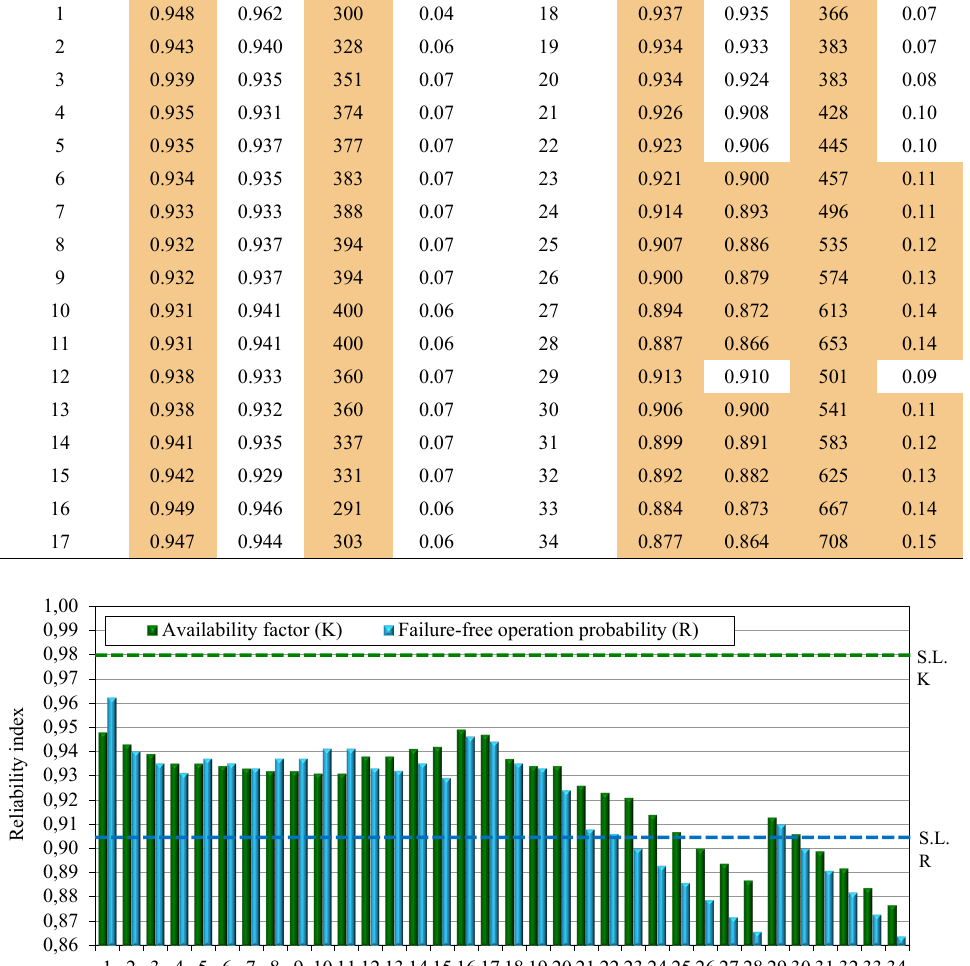
Fig. 9. Nodal RI of DHS in Shelekhov (number of consumers correspond to Fig. 3 and Fig. 6; S.L. – standard level). As can be seen from the Table 5 and Fig. 9, the RI values differ significantly among consumers. Consumers located far from the HS, and connected to the non-reserved (non- circuit) part of the network, have the lowest level of reliability of both the designed and reduced heat supply. Index K takes values in range from 0.877 (consumer 34) to 0.949 (consumer 16); and index R takes values in range from 0.864 (consumer 34) to 0.962 (consumer 1). Index Z for the most “unreliable” consumer 34 is 708 hours, and the number of heat supply failures N is 0.15 1/year or one time in 6.8